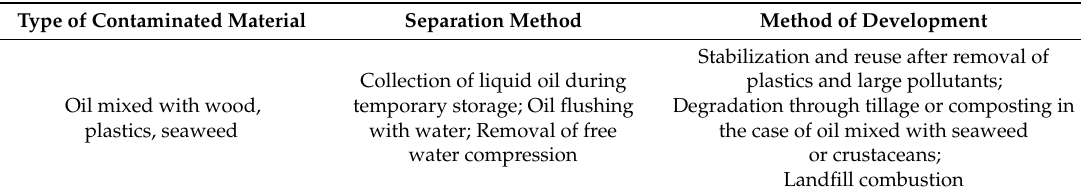
Table 2. Main options available for separation and disposal of oil and debris